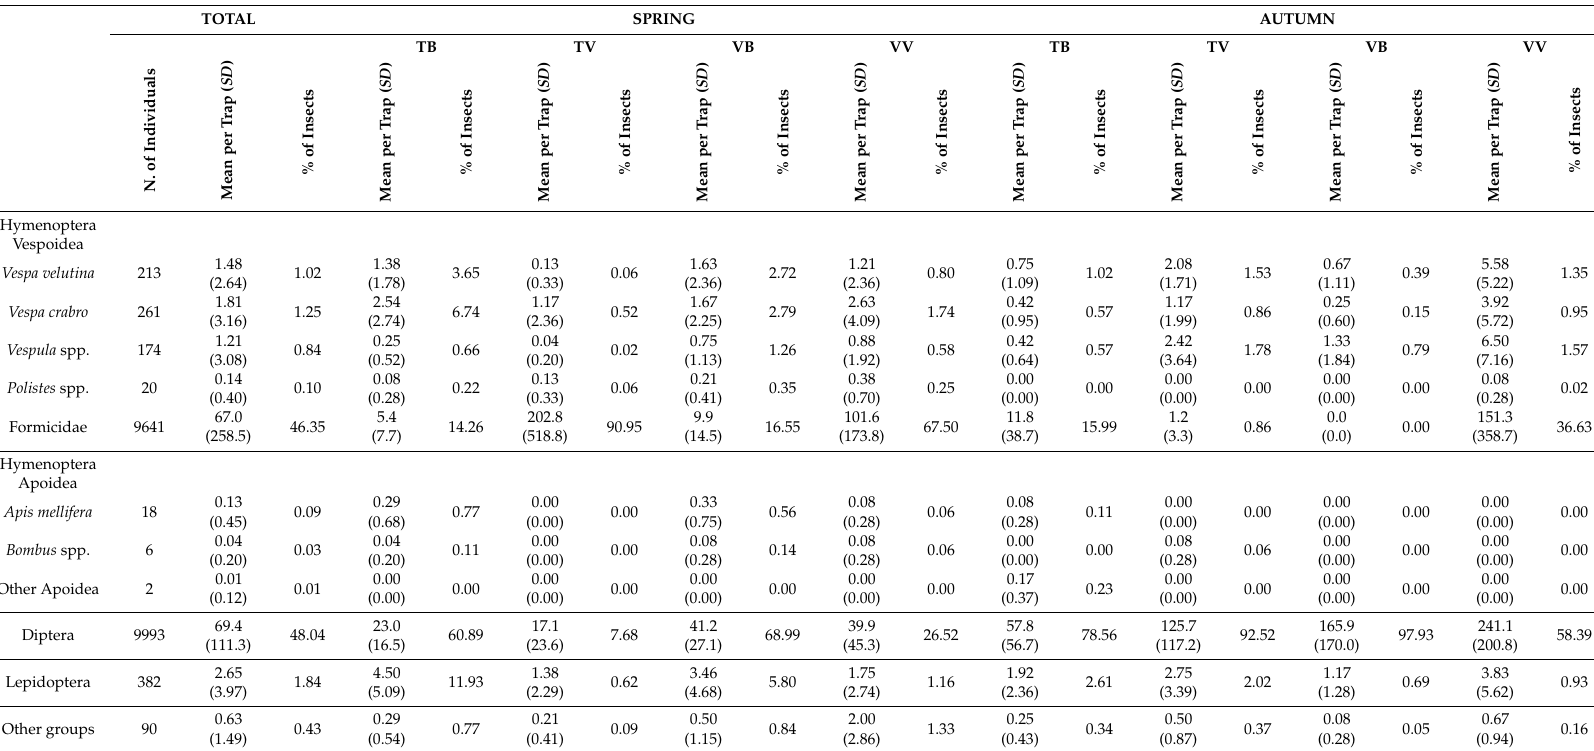
Table 1. Overall trapping results in the two sampling sites (total column) and results divided between spring and autumn taking into account the four trap–bait combinations. For each period, the mean number of individuals per trap (standard deviation in brackets) and the percentage of trapped individuals for the corresponding species / group out of the total number of trapped insects are